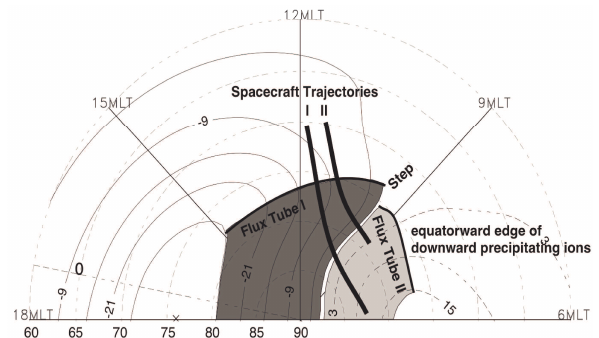
Fig. 11. Ionospheric convection cells derived from the statistical element of the SuperDARN “map potential” model for − B Z and − B Y IMF input, in order to illustrate how major cusp structures could be spatial instead of temporal. Two flux tubes and two satel- lite trajectories have been superimposed on the convection cells. (From Trattner et al.,